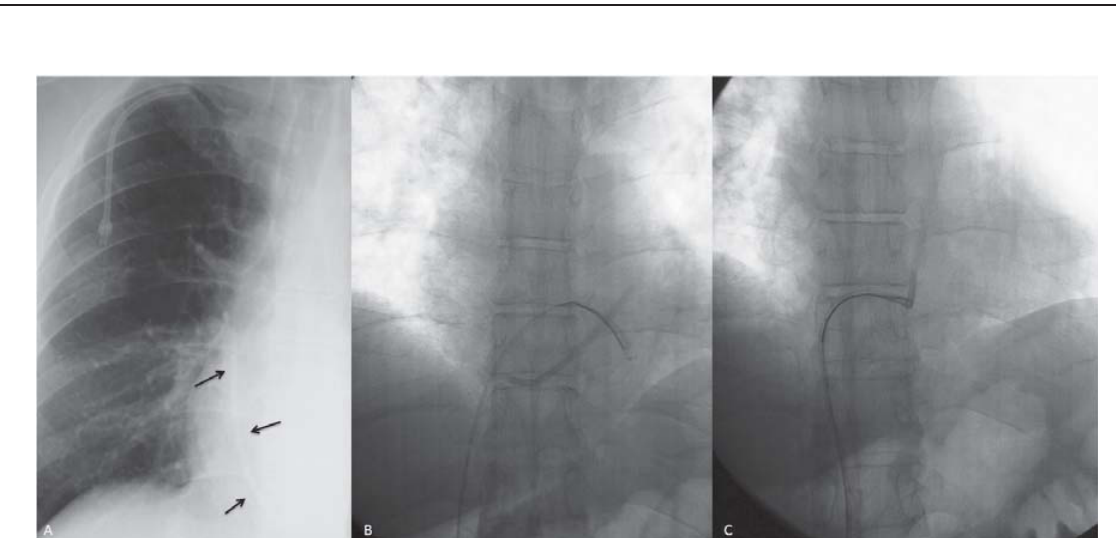
Fig. 4 - A: Radiografia simples do tórax demonstrando fragmento de cateter dentro do ventrículo direito. B: Cateter totalmente dentro do ventrículo direito. Posição desfavorável para captura. C:Captura do cateter com laço, previamente mobilizado para o tronco da artéria